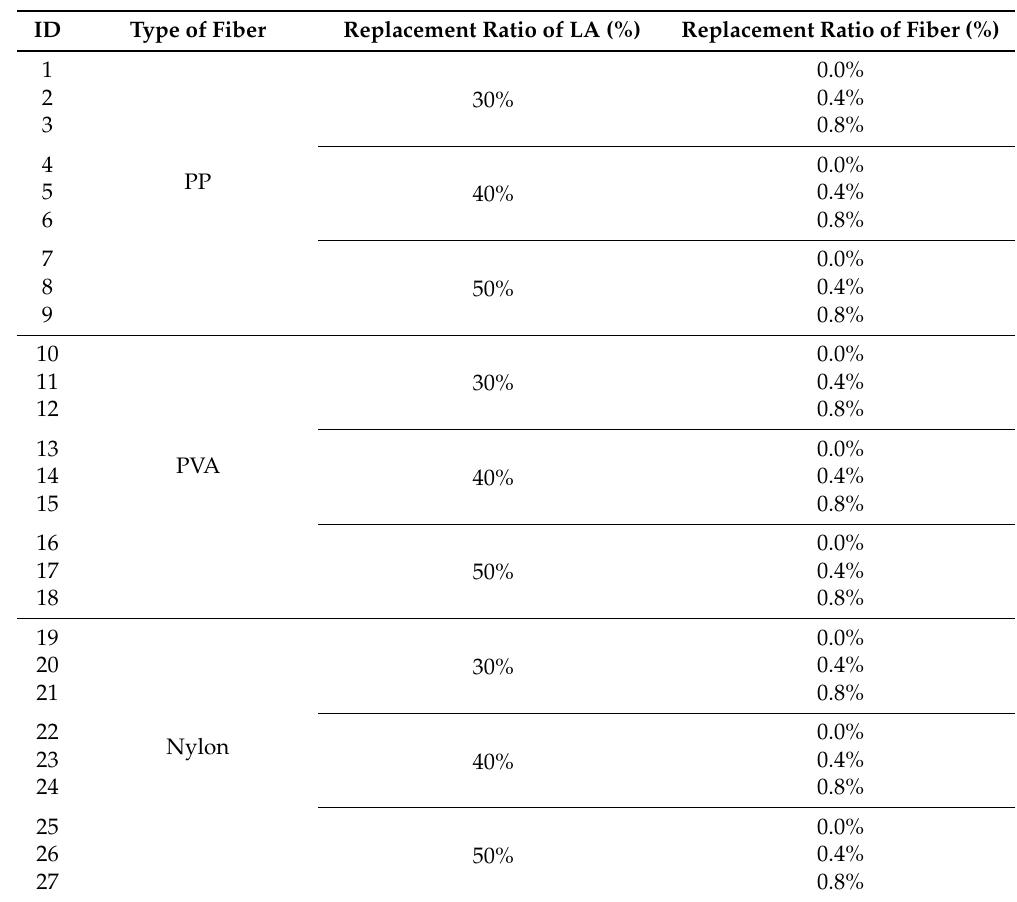
Table 3. Mix conditions for the experimental